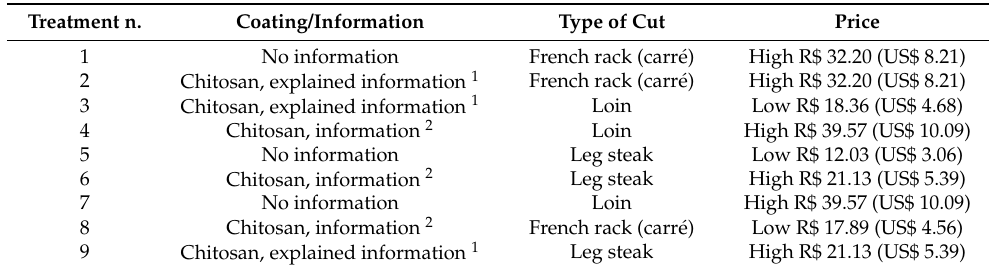
Table 2. Factors and levels of the fractionated factorial design used in this study. Treatment